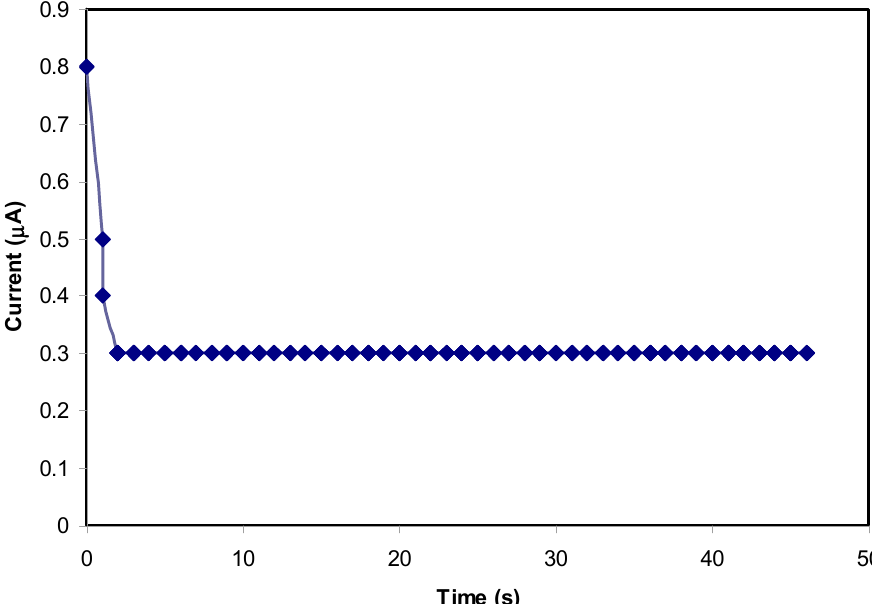
Figure 7. Polarization current for PCSH5 conduction sample versus time.